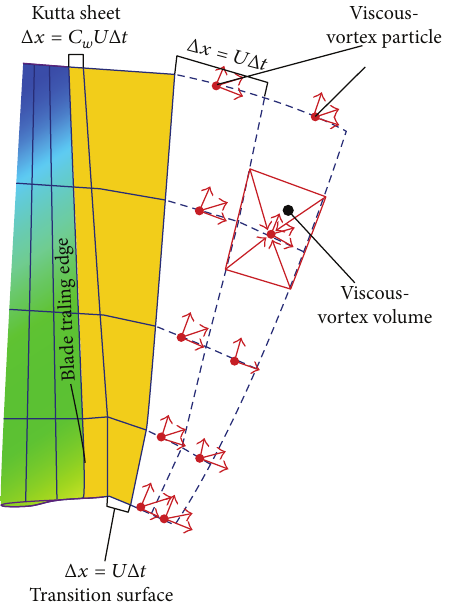
Figure 2: Schematic of the panel and particle wake vortex method.